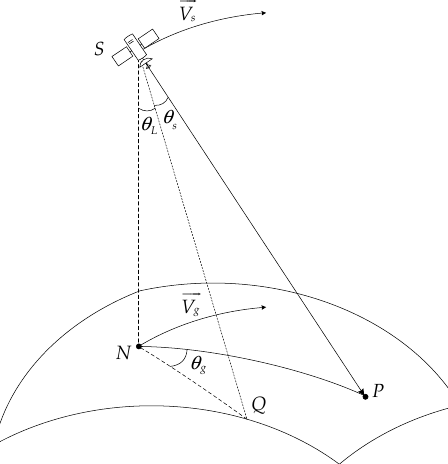
Figure 12. The observation angle relationships in GEO SAR. S denotes the satellite position, P is the target position on the ground, and N is the nadir point. SP is the beam-center line. SNQ is the zero-Doppler plane, SNP is the squint plane, θ L is the elevation angle, θ s is the squint angle, and θ g is the ground squint angle.